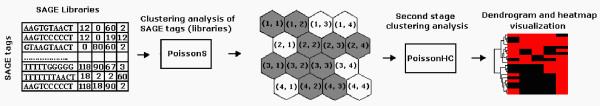
An example of the combination of PoissonS and PoissonHC for SAGE data analysis with PoissonS as the first analysis level and Poisson HC clustering prototypes originating from PoissonS and SAGE tags assigned to each node. Such a combination may highlight inter- and intra-cluster relationship hidden in the SAGE data.